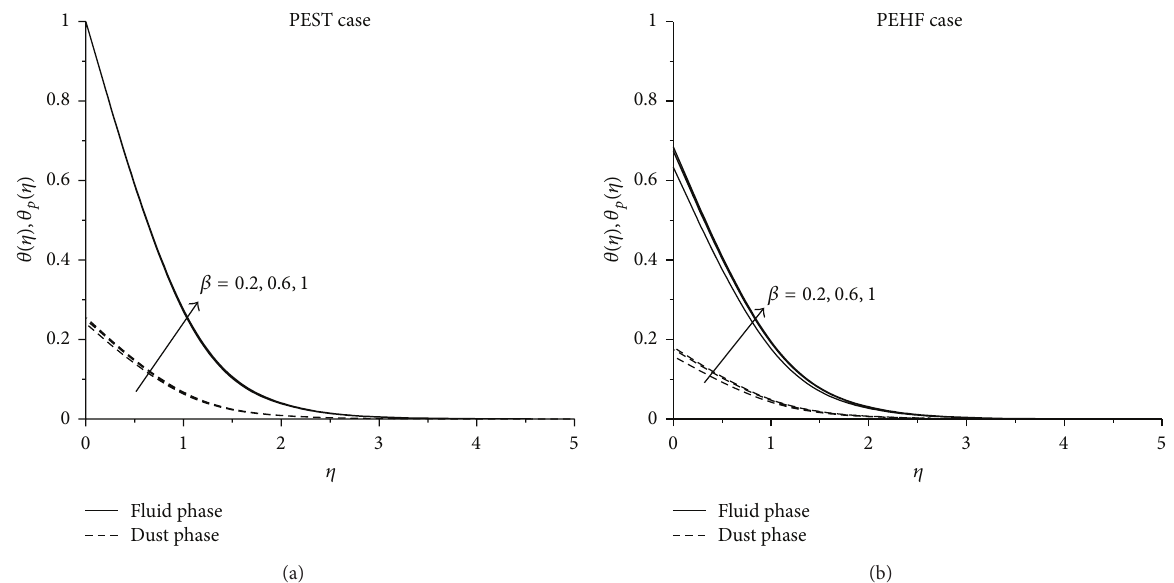
Figure 4: Effect of 𝛽 on temperature profiles for both PEST and PEHF cases with 𝑁 = 𝜆 = Ec = 𝑆 = 0.5 and Pr = 0.72 .